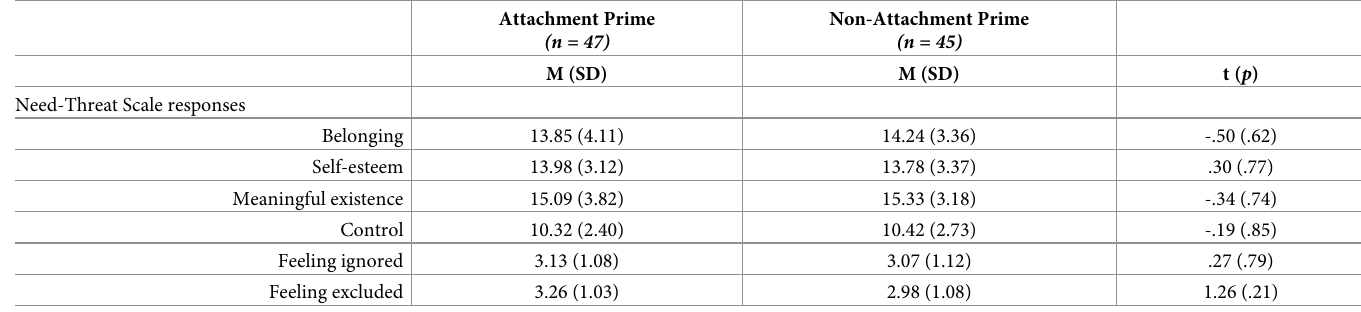
Table 2. Need-threat scale